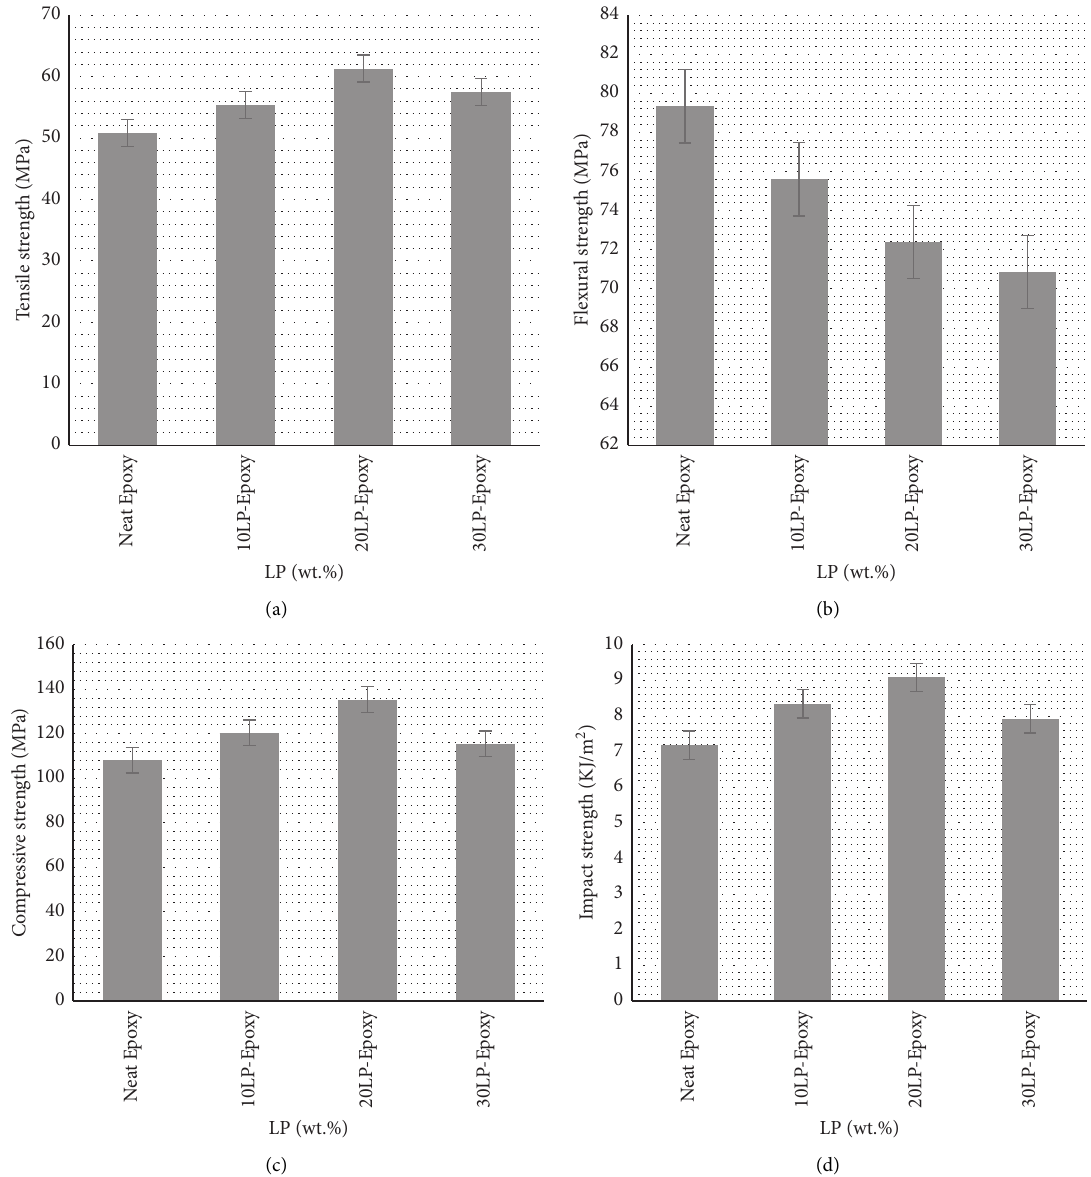
Figure 3: Mechanical properties of epoxy composites reinforced with lychee peels at the following ratios: 0 wt% LP, 10 wt% LP, 20 wt%, and 30 wt%